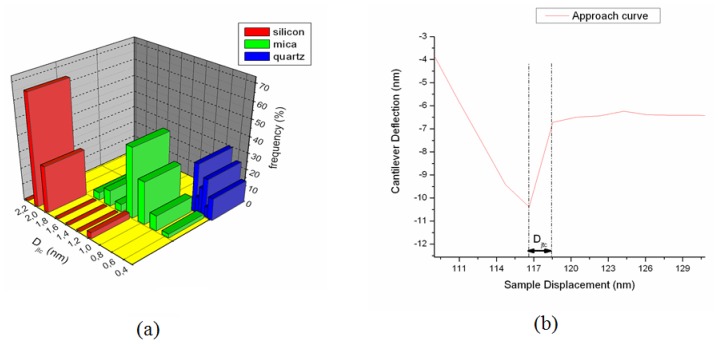
(a) Histogram illustrating the values of jump-to-contact distance in air (RH ≈ 70%) for sample surfaces of mica, quartz and silicon; (b) Typical force curve enlarged in the attractive region, illustrating the thickness of the liquid film determined by AFS (kc ≈ 0.13 N/m) (Reproduced by permission of Taylor and Francis Ltd. [29]).